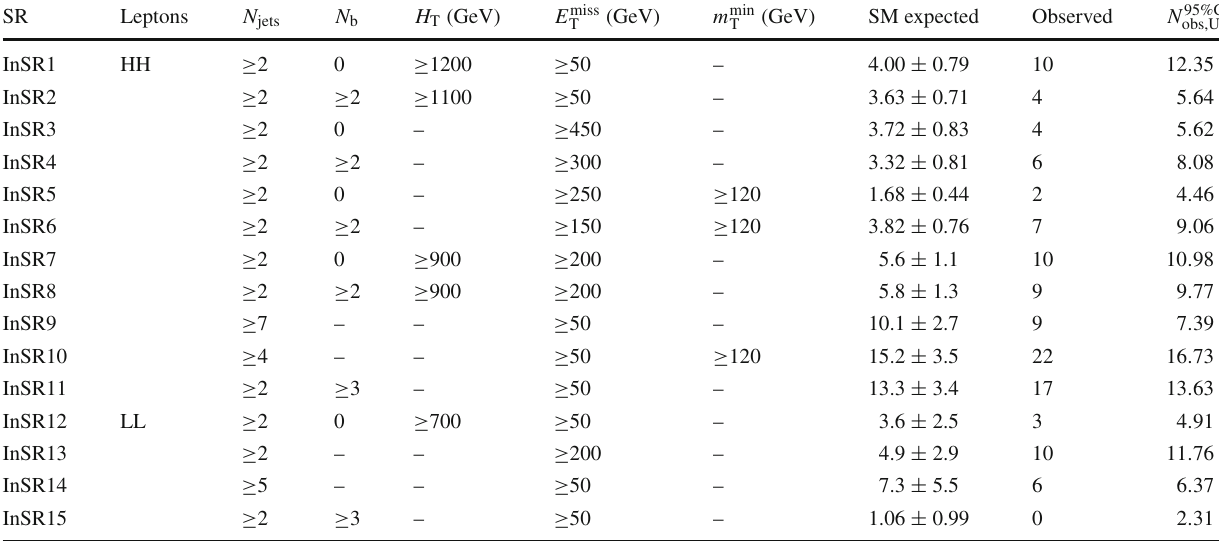
Table 7 Inclusive SR definitions, expected background yields, and observed yields, as well the observed 95% CL upper limits on the num- ber of signal events contributing to each region. No uncertainty in the